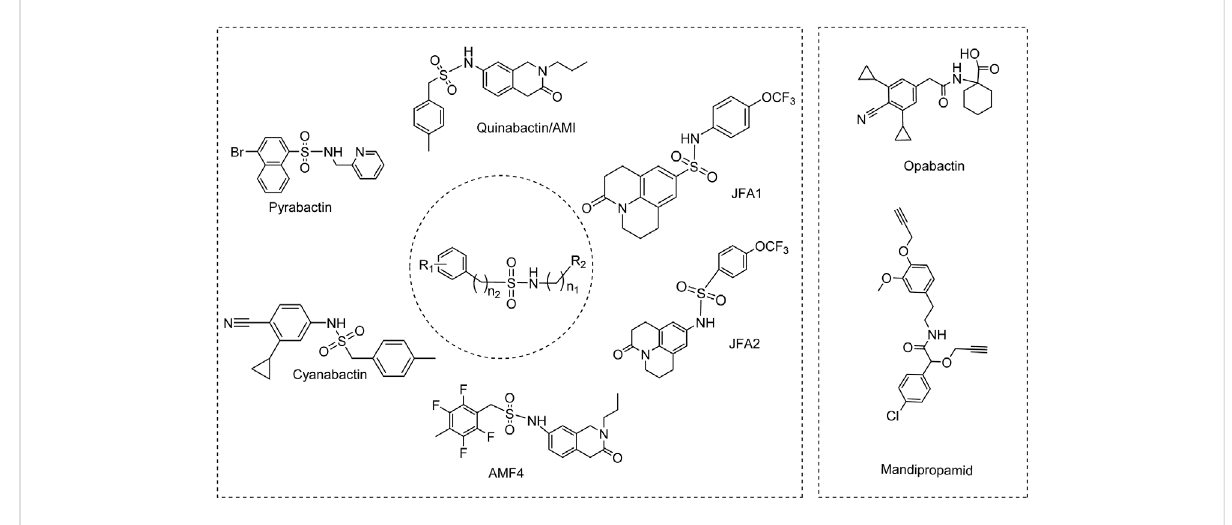
FIGURE 5 Abscisic acid functional